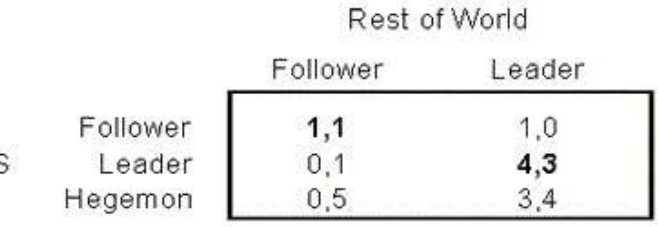
Table 4.5 A simple model of the world political economy, 19 71 ·1995 [Page